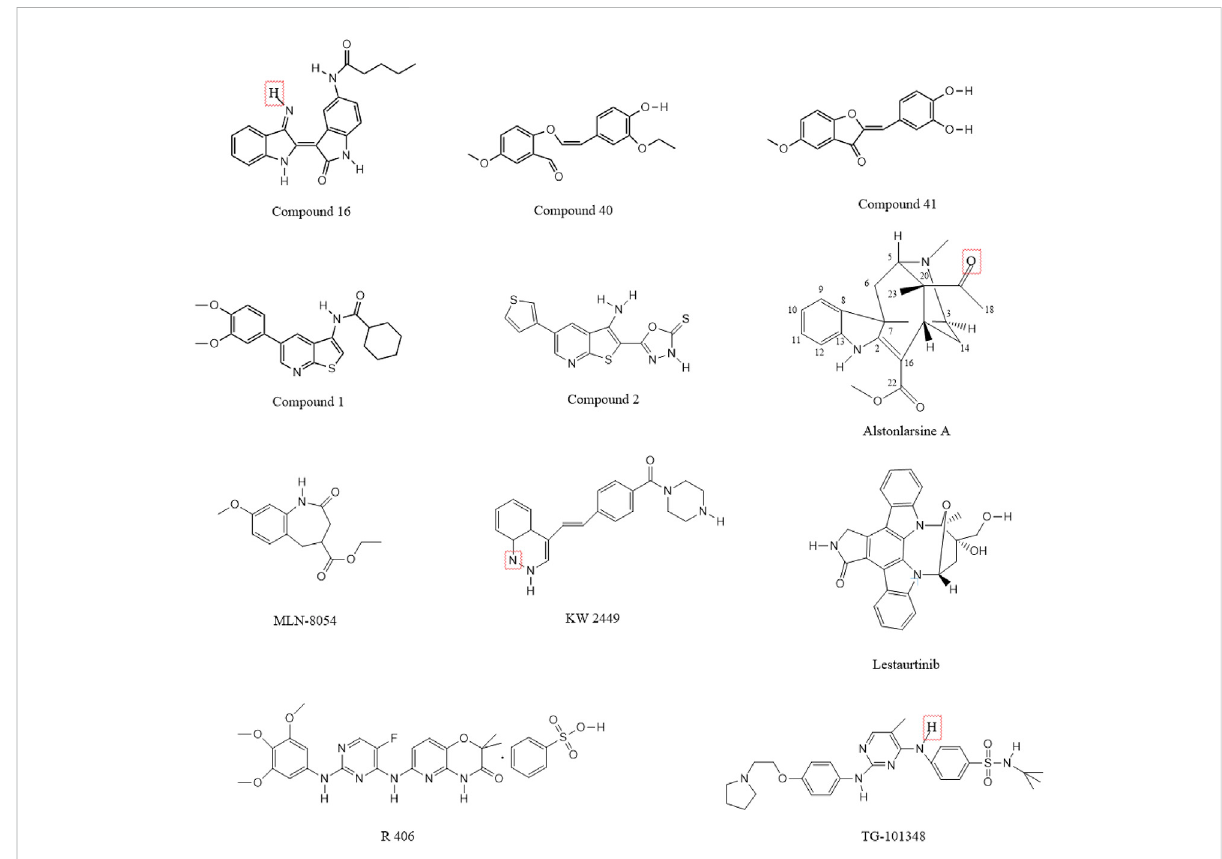
FIGURE 6 Chemical structure formula of DRAK2 small molecule